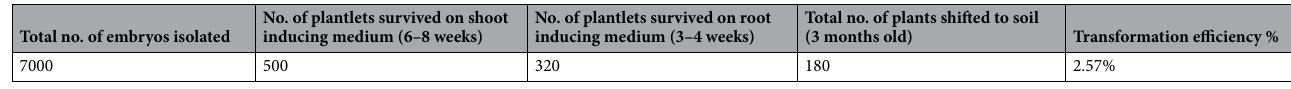
Table 1. Transformation efficiency of cotton embryos used in different